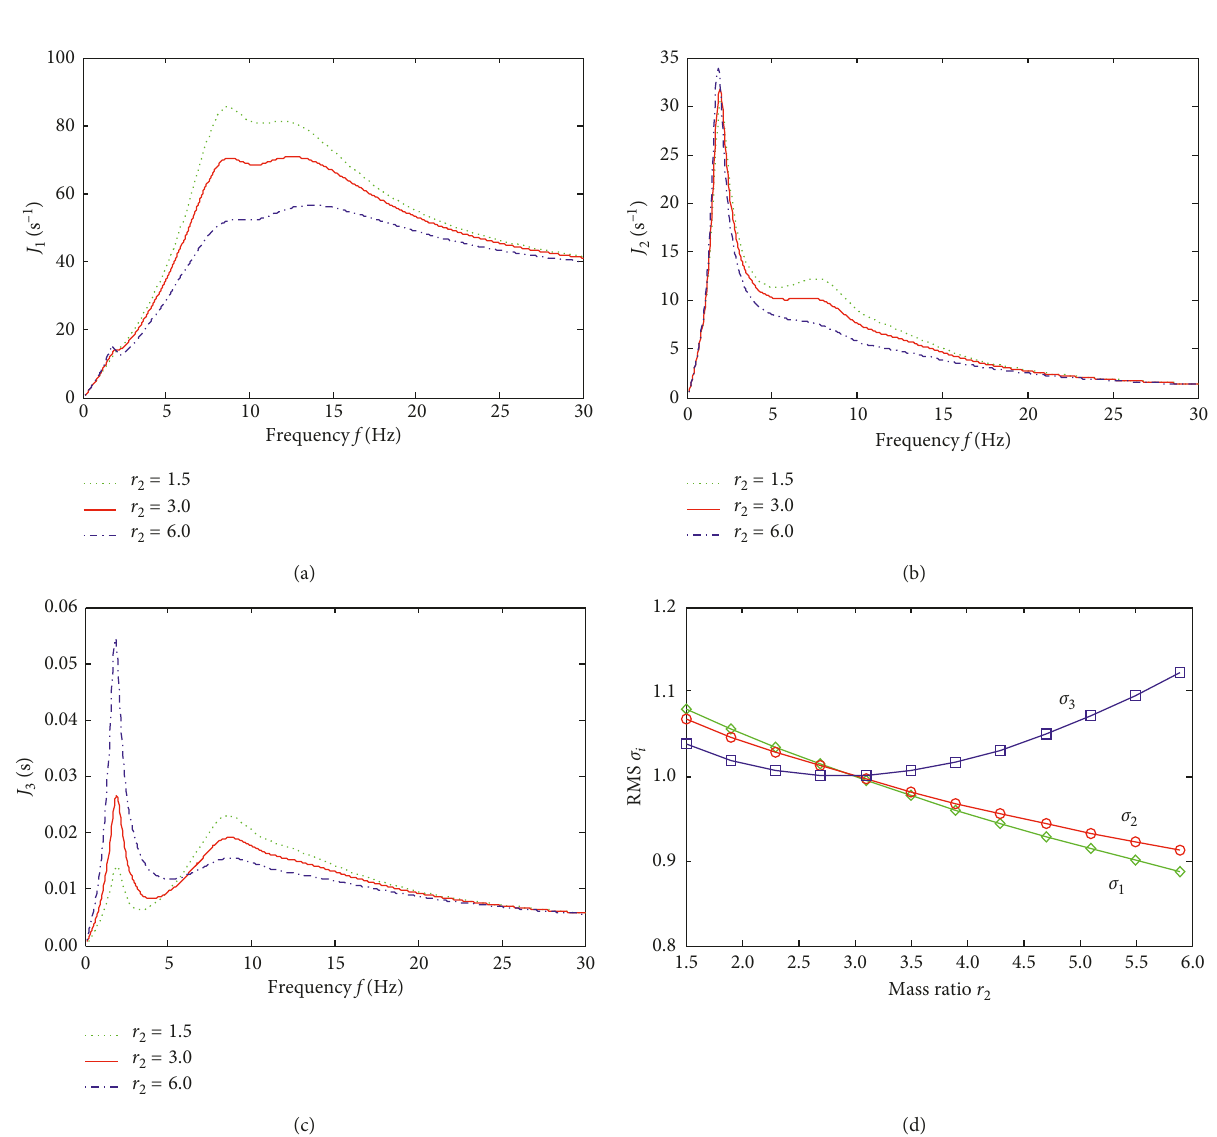
Figure 4: Influences of r frequency characteristics J and σ versus r 3 2